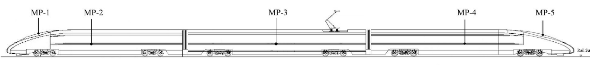
Figure 3. Distribution of measurement points.